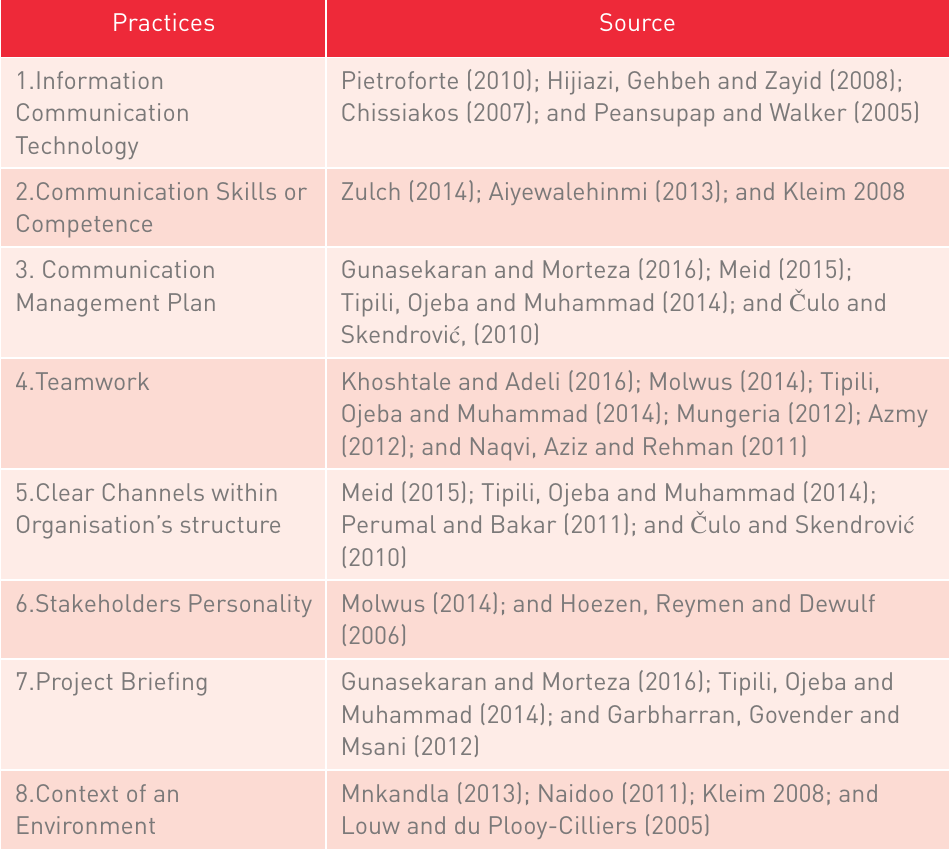
Communication management practices